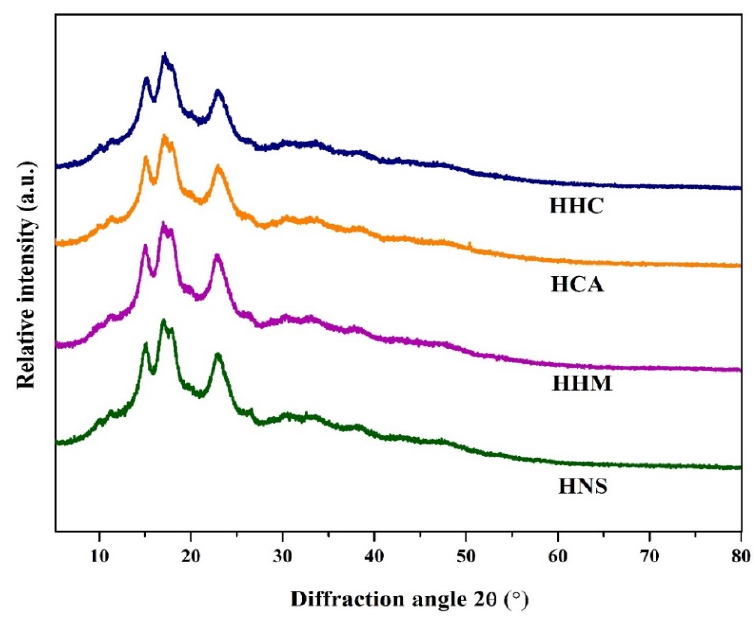
Figure 1. X-ray diffraction pattern of native and modified Hausa potato starches.